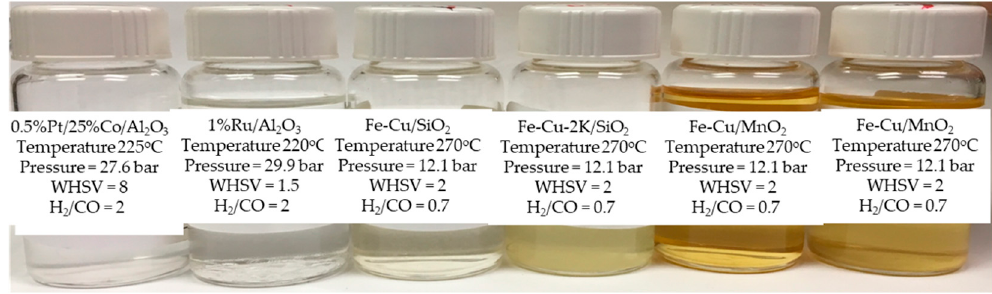
Figure 2. Deviations in the color of oils produced by Fischer–Tropsch synthesis (FTS).